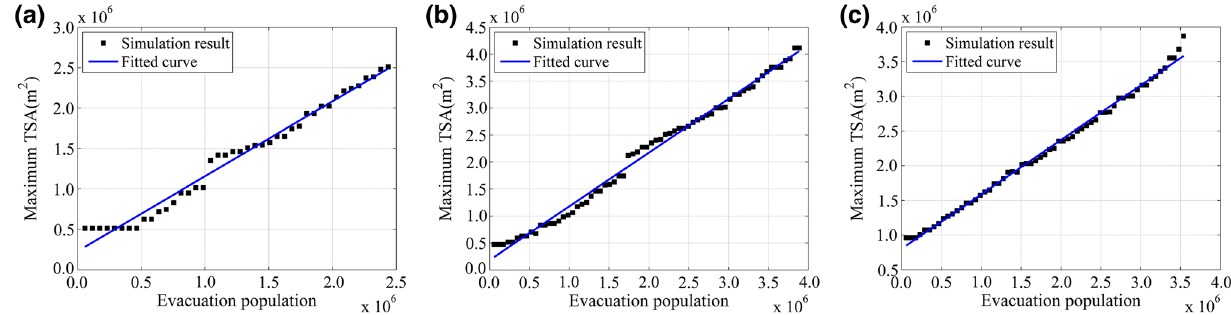
Fig. 7 Relationships between evacuation population and minimum total shelter area (MIA). a – c Location 1, Location 2, and Location 3,